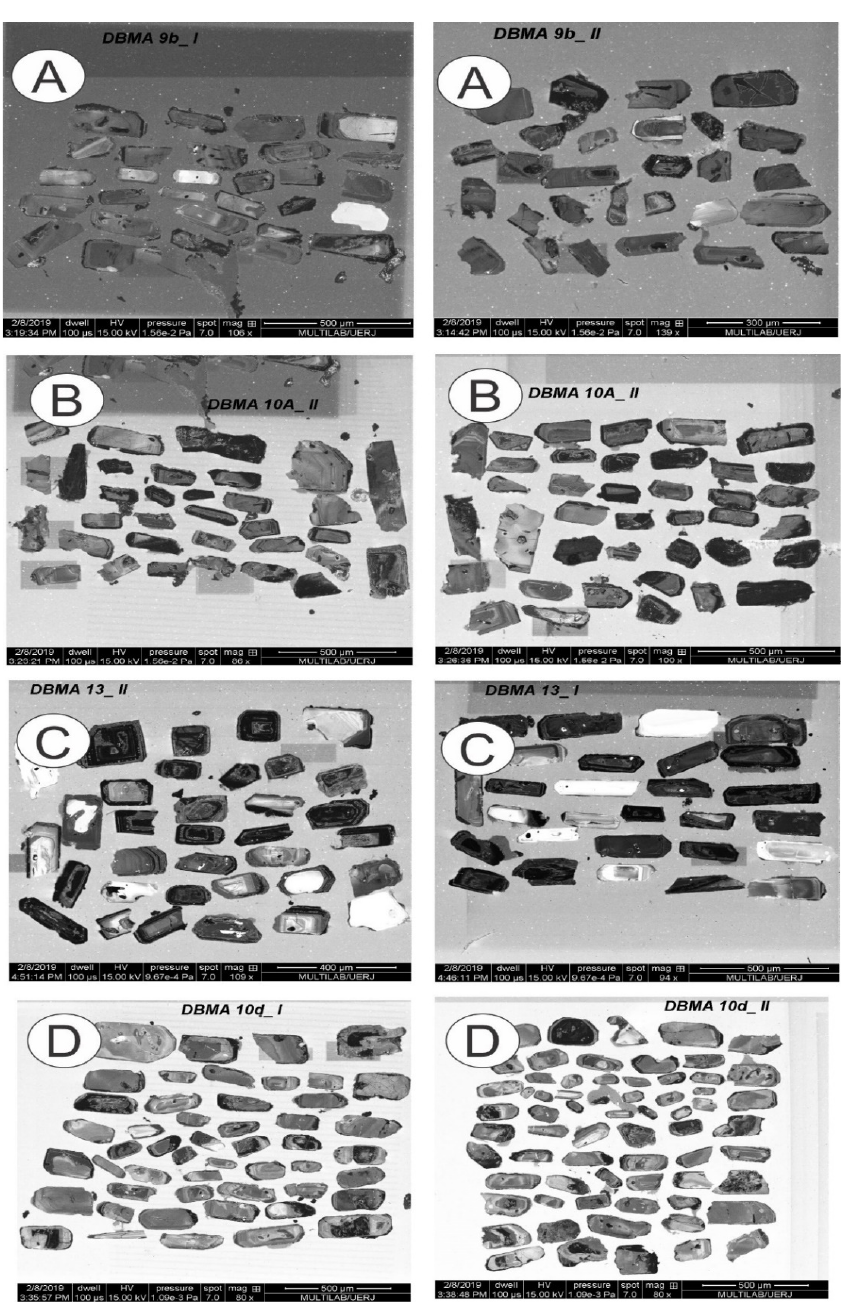
Figure 17. Cathodoluminescence images of zircon grains from samples: ( A ) DB-MA-9B; ( B ) BD-MA- 10A; ( C ) BD-MA-32 and; ( D ) BD-MA-33.